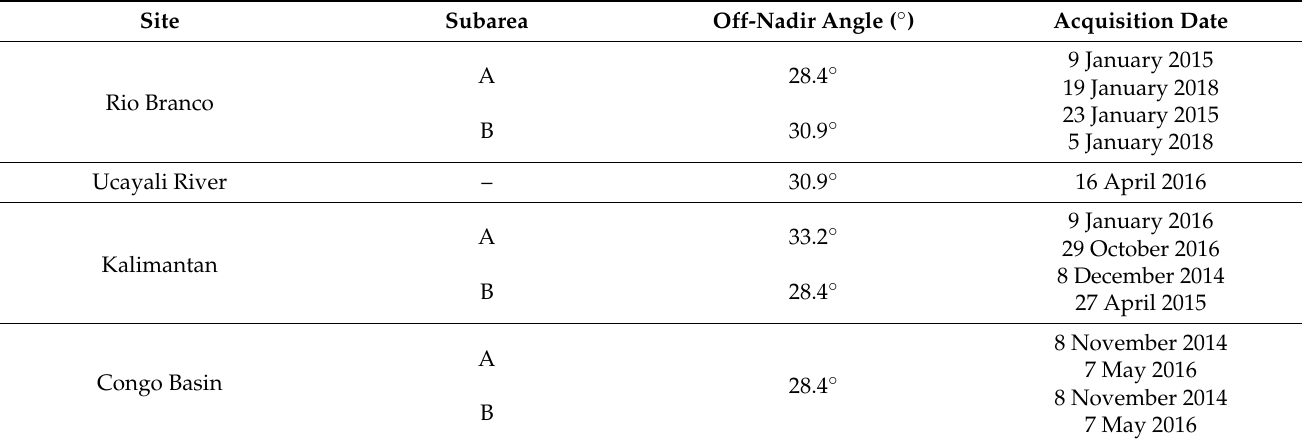
Table 1. Main characteristics of POLSAR data from PALSAR-2 used in this